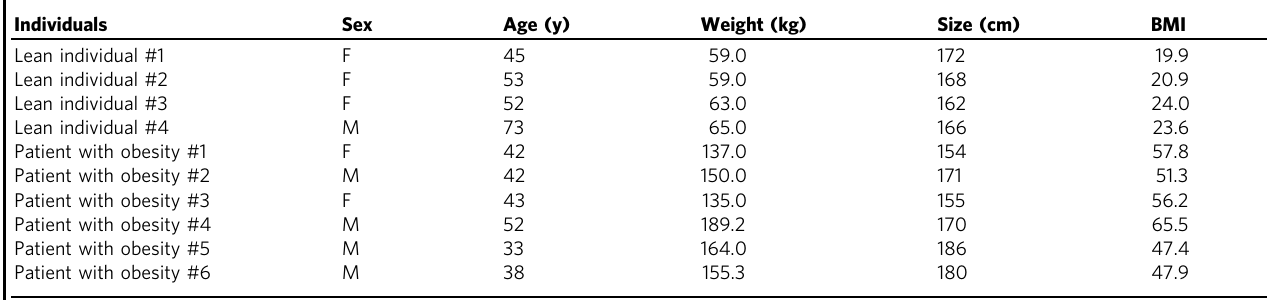
Table 2 E4F1 expression in patients with obesity.